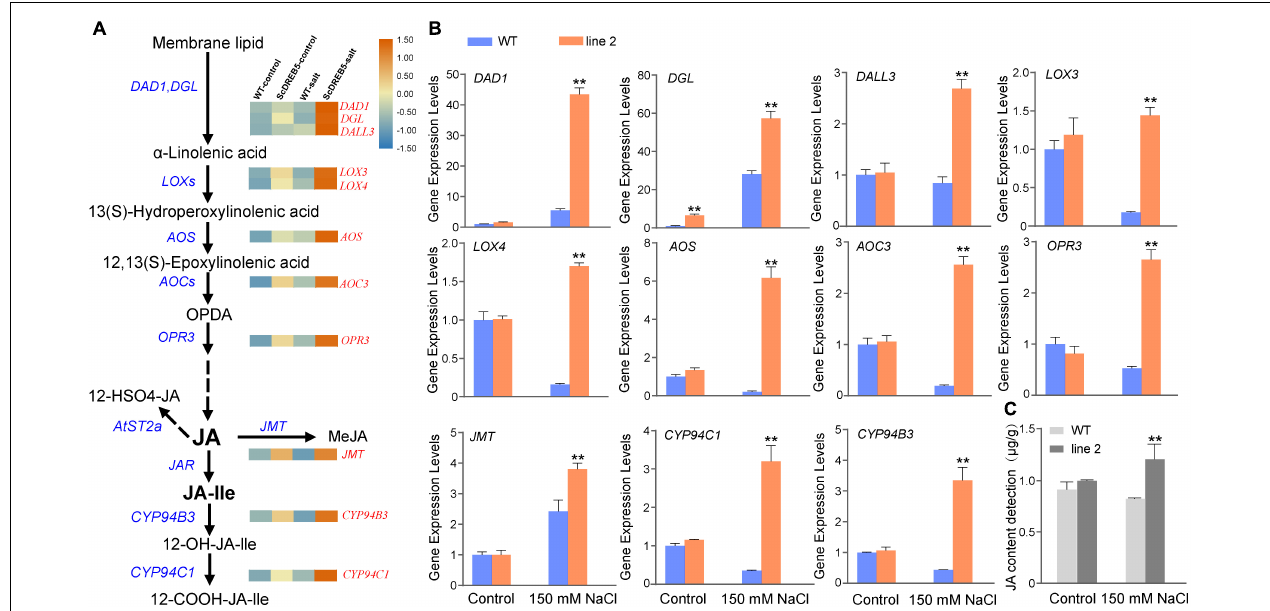
FIGURE 7 | Transcriptome data were used to create heatmaps of the relative expression levels of JA biosynthesis, expression analysis of JA biosynthesis related genes, JA content detection. (A) Expression profiling of 11 JA biosynthesis genes which is significantly increased in transgenic plants. These heatmaps were created using TBTools. The FPKM values of the four samples are normalized by a row scale function, the expression levels from low (blue) to high (orange) indicate the minimum and maximum values for the same row. (B) Eleven JA biosynthesis related genes were selected for RT-qPCR analysis in WT and ScDREB5 transgenic plants under normal and salt stress conditions. The α -TUBULIN ( AT1G50010 ) gene of Arabidopsis was used as the reference gene. (C) JA content detection. Values are means ± SE of three replicates. Significant difference compared with WT plants with the same treatment. LSD multiple comparison test was used: * p < 0.05, ** p <